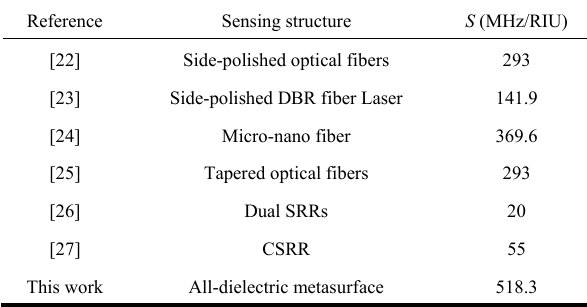
Table 1 Performances of GHz sensors including type of sensing structure and sensitivity of the developed